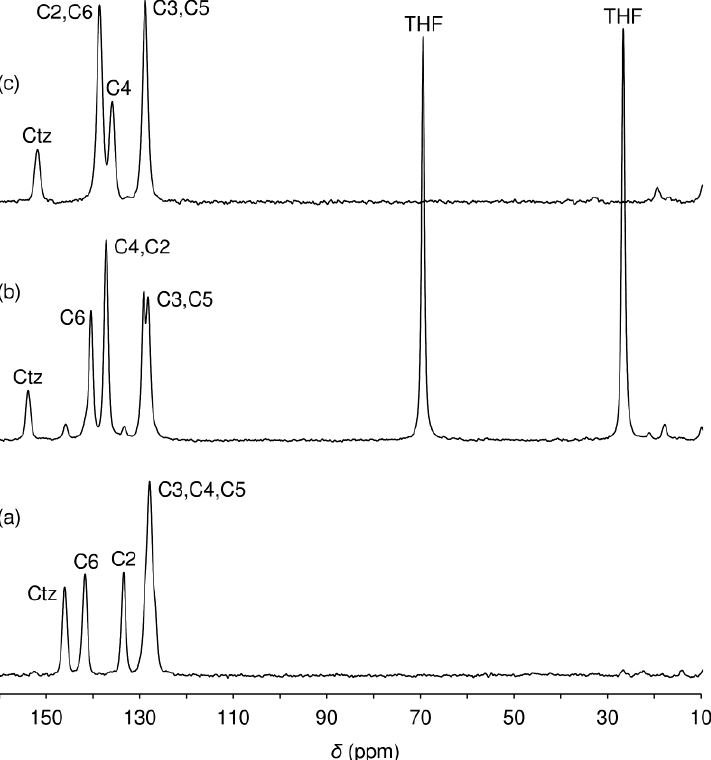
Figure 5. 13 C{ 1 H} CP MAS NMR spectra of ( a ) ligand Hpto, ( b ) complex 1 , and ( c ) compound 2 .